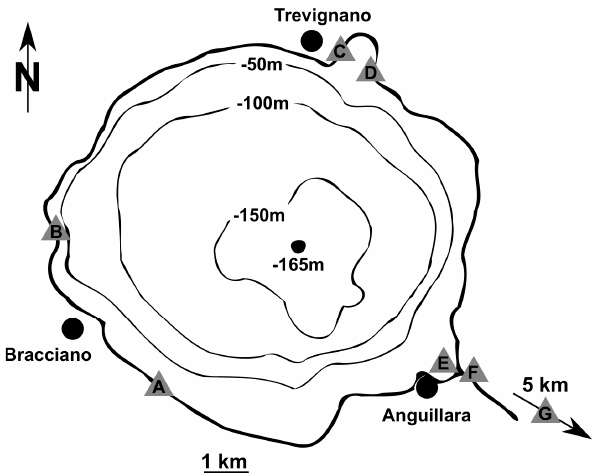
Figure 1. Bathymetric map of Lake Bracciano (Italy), including the sampling sites (triangles A–G) and the water depth from the surface (after [13]).